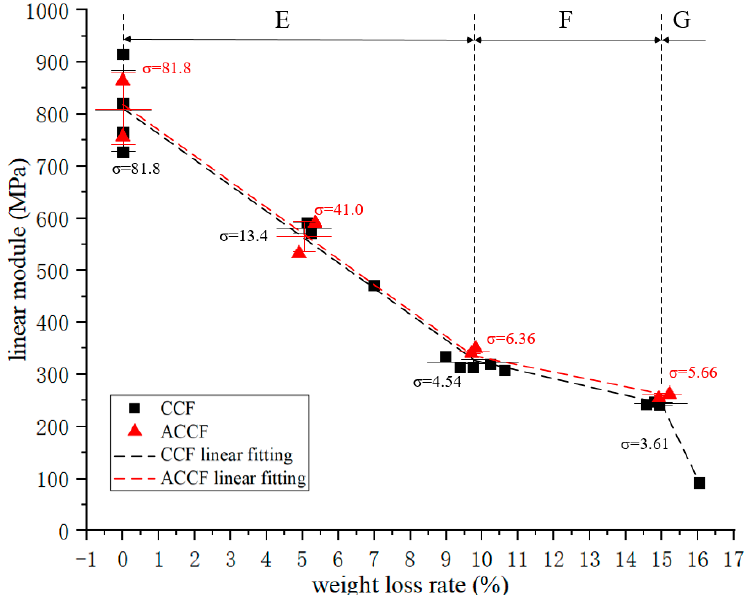
Figure 3. Compression modulus–weight loss rate curve.